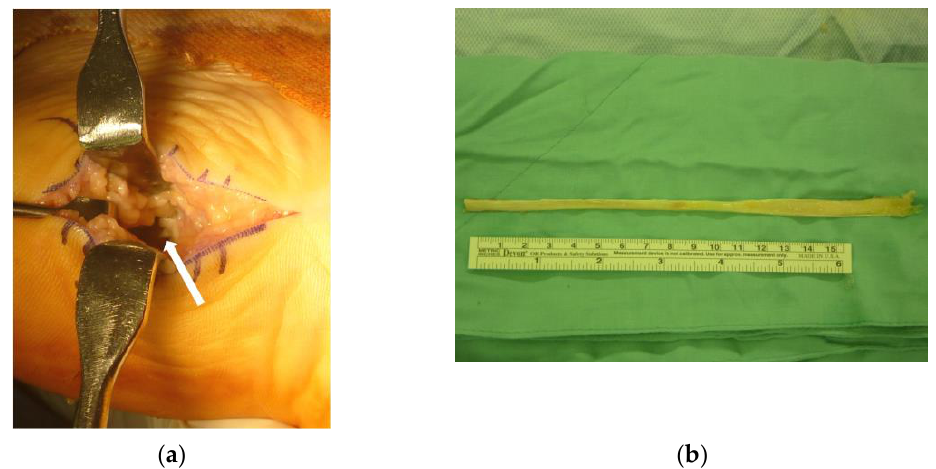
Figure 2. ( a ): The white arrow indicates the ruptured plantar fascia with a 3-cm gap even after extreme plantarflexion. ( b ): The extensor hallucis longus allograft obtained from our bone bank. The fascia was reconstructed with a tendon allograft using the Pulvertaft weaving technique (Figure 3).